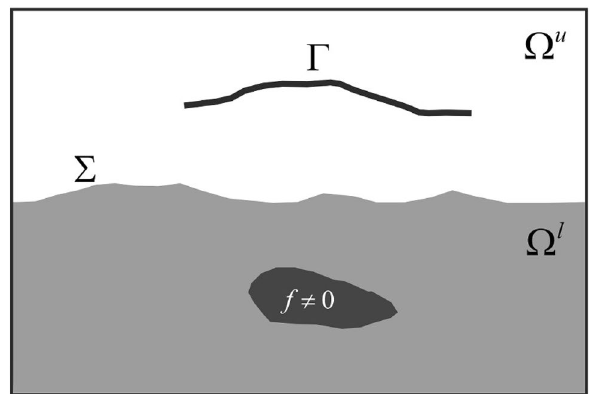
Figure 1. Two-dimensional cartoon of the model domain (cid:31) . Dark gray: the area of non-zero current source l u density; light gray: the SSD (cid:31) ; (cid:31) is the ISD; (cid:31) is the OSD; and Ŵ is a curve (or a set) of measurement